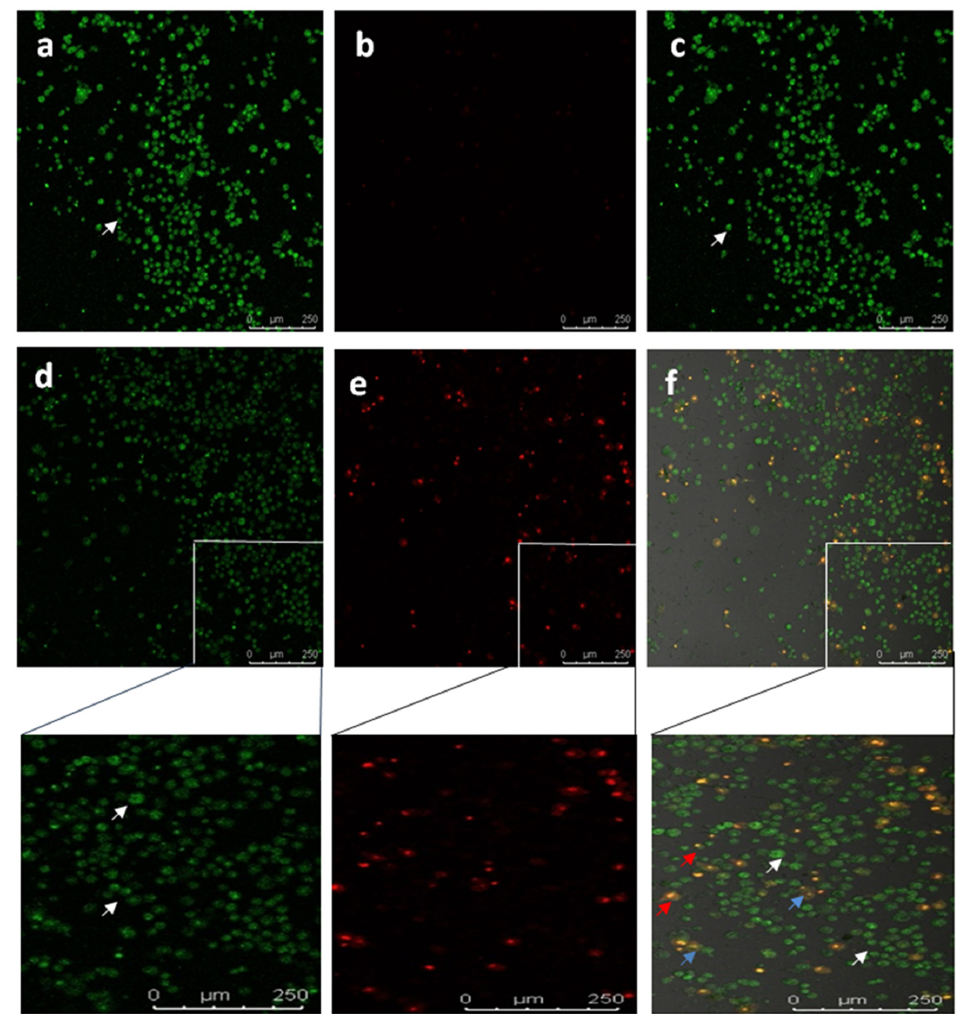
Figure 8. Confocal images showing live-dead (Thiazole orange/Propidium iodide) staining in U87-MG cells. Untreated U87-MG cells showed normal cellular structure (white arrows).Apoptotic cell (blue and red arrows) includes cell membrane blebbing and chromatin condensation, respectively. ( a ) TO, ( b ) PI, ( c ) overlay image of untreated; ( d ) TO, ( e ) PI, ( f ) overlay image treated with PCL-F68-D-NPs.